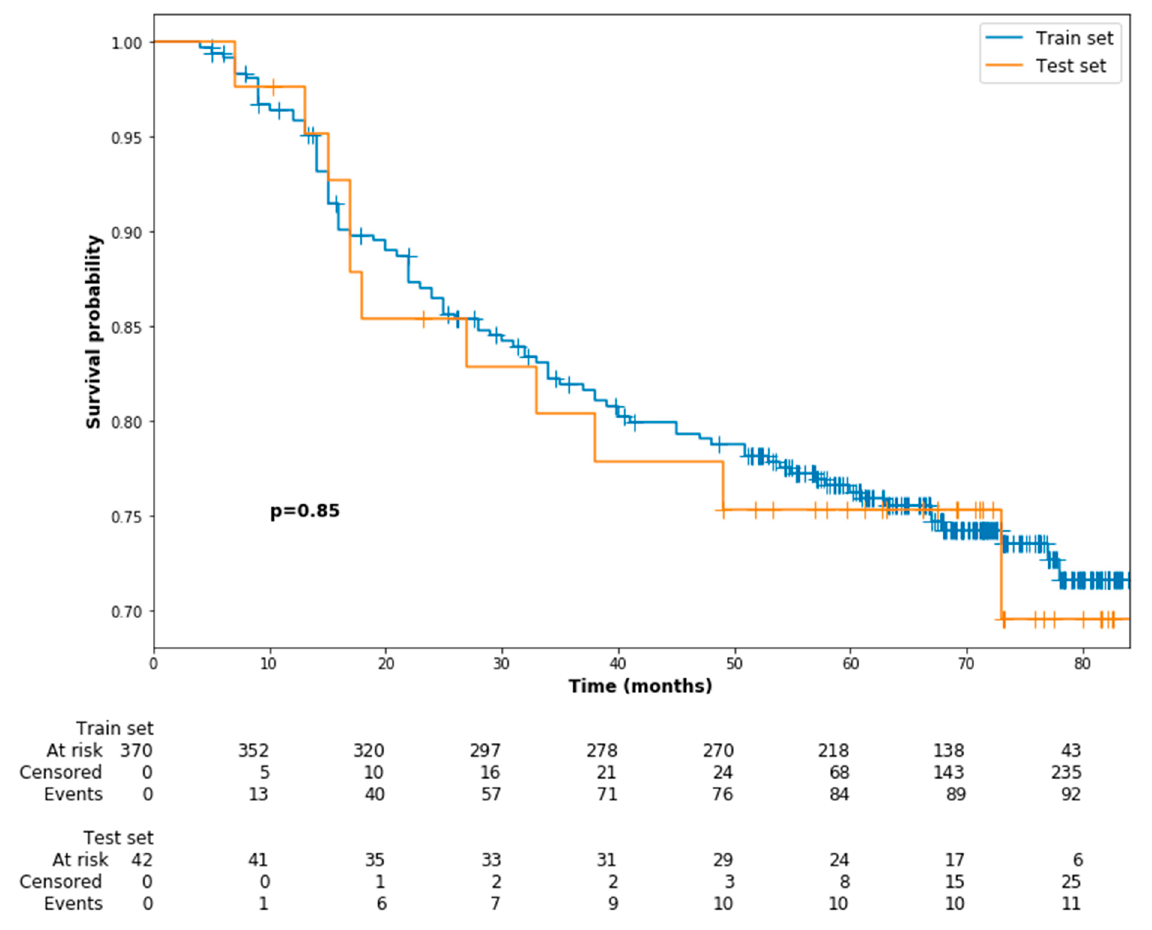
Figure 2. Kaplan–Meier survival curves of progression-free survival for the training cohort and testing cohort.